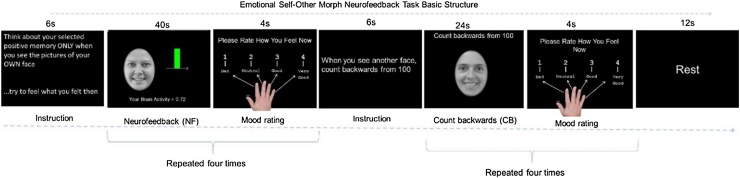
Emotion Self-Other Morph Neurofeedback (ESOM_NF): Conditions and timings.